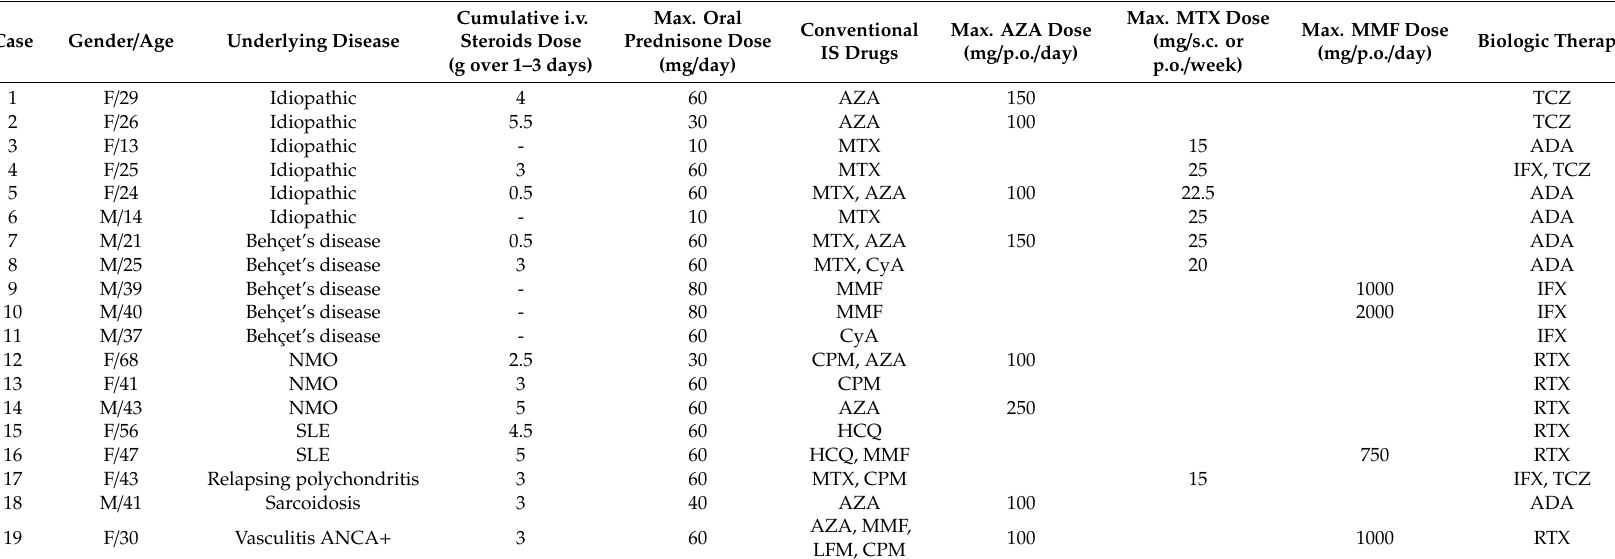
Table 1. Main features of 19 patients with refractory non-Multiple Sclerosis Optic Neuritis treated with biologic